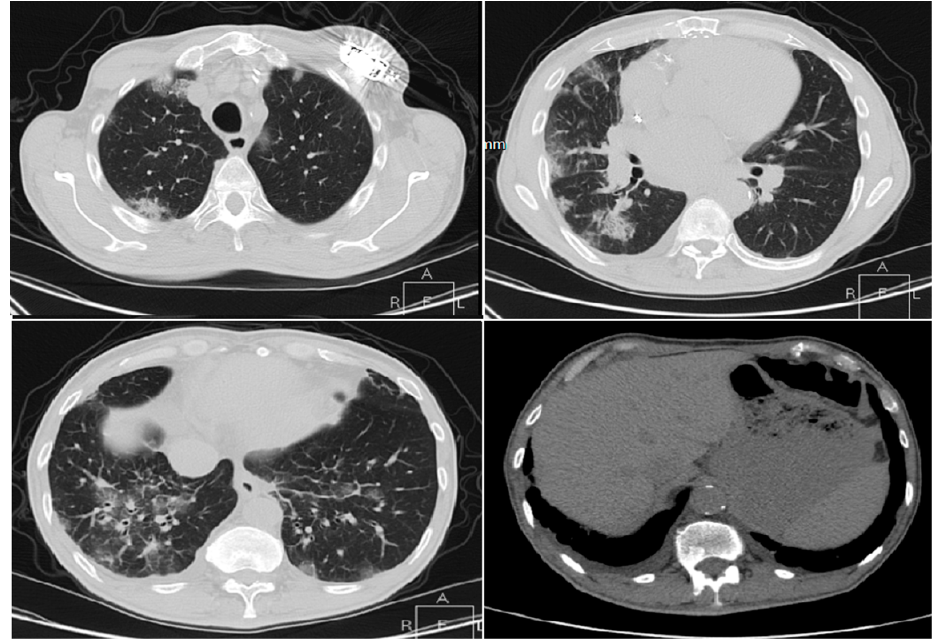
Figure 8. Chest MDCT scan, lung window, axial plane: Bilateral multilobar multifocal ground glass opacities with random peripheral and peribronchovascular distribution are seen, more prominent in right lung. Bilateral mild pleural effusion is seen.